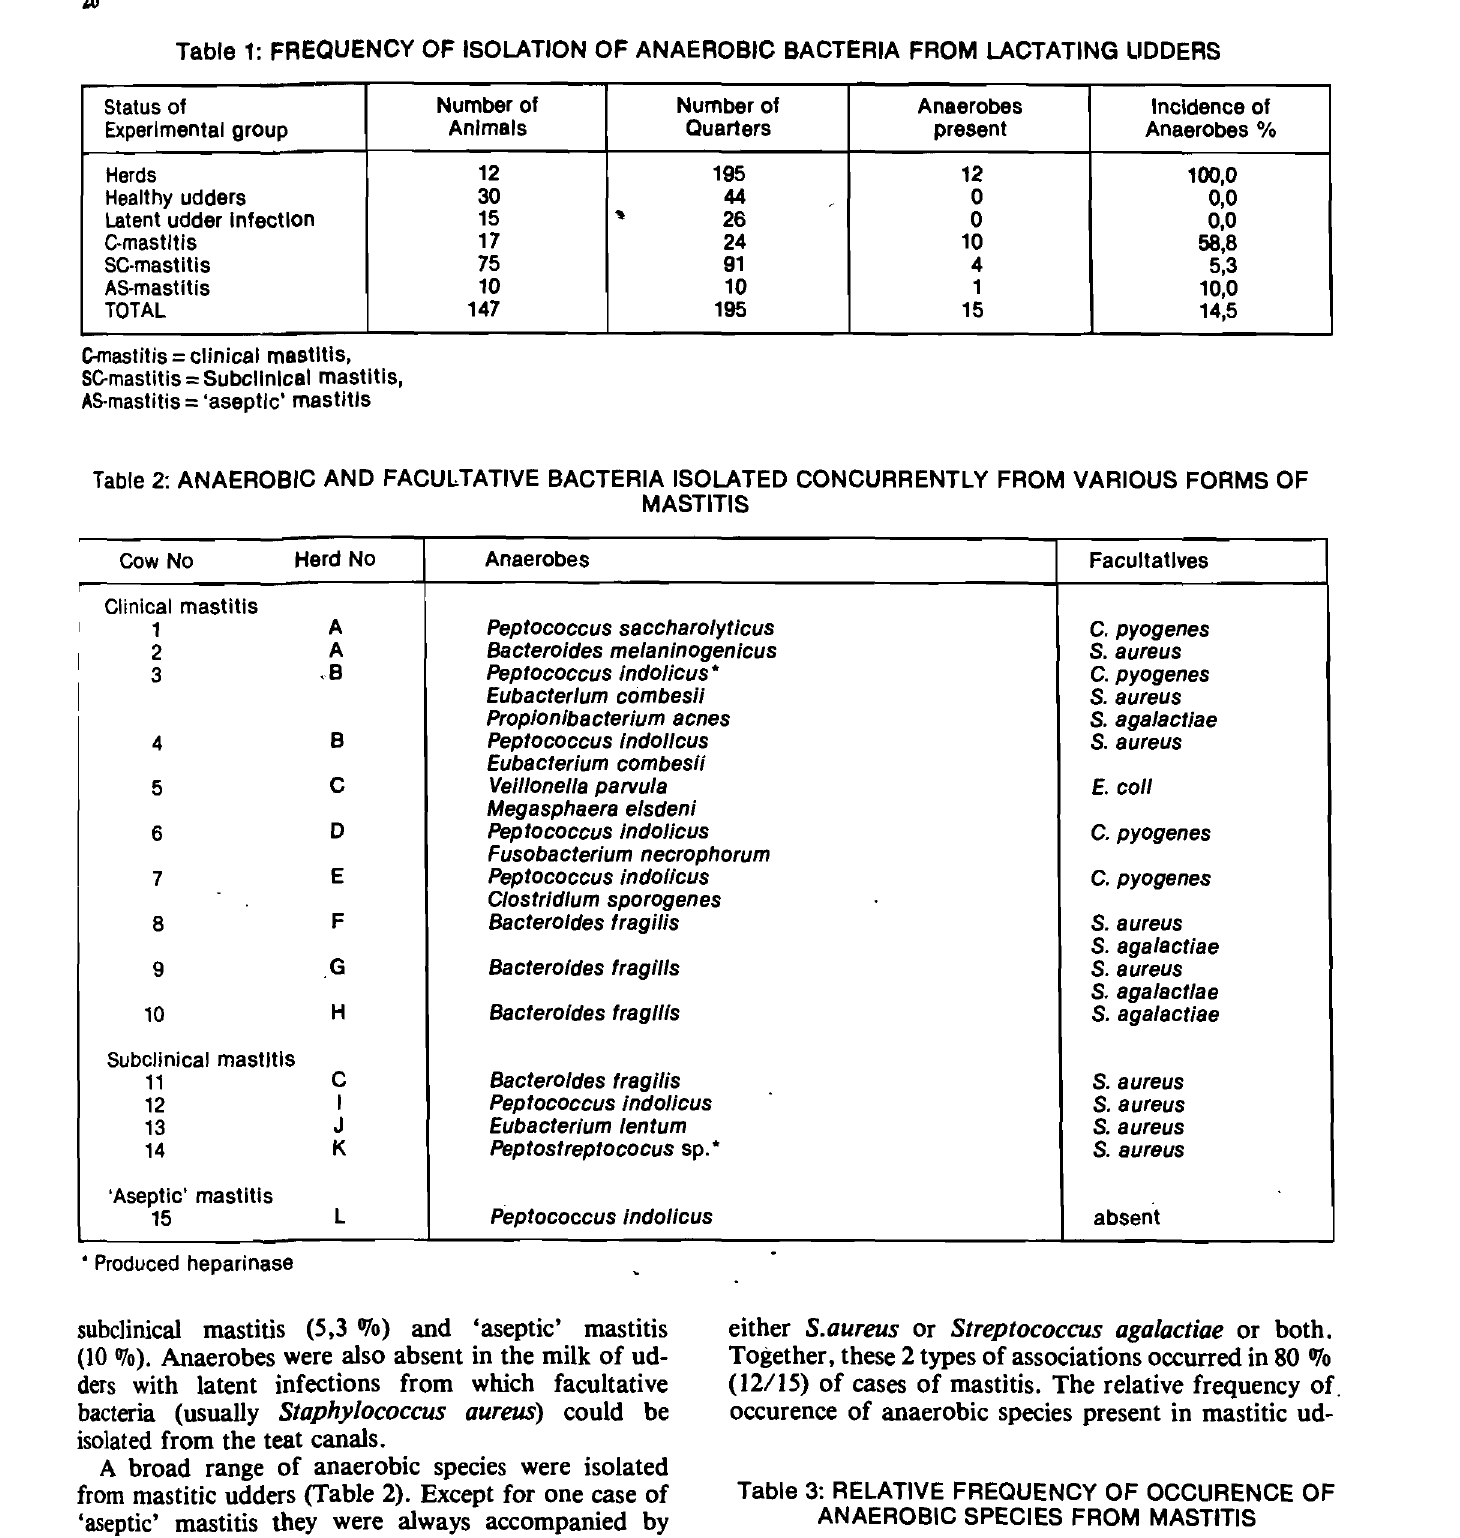
Table 3: RELATIVE FREQUENCY OF OCCURENCE